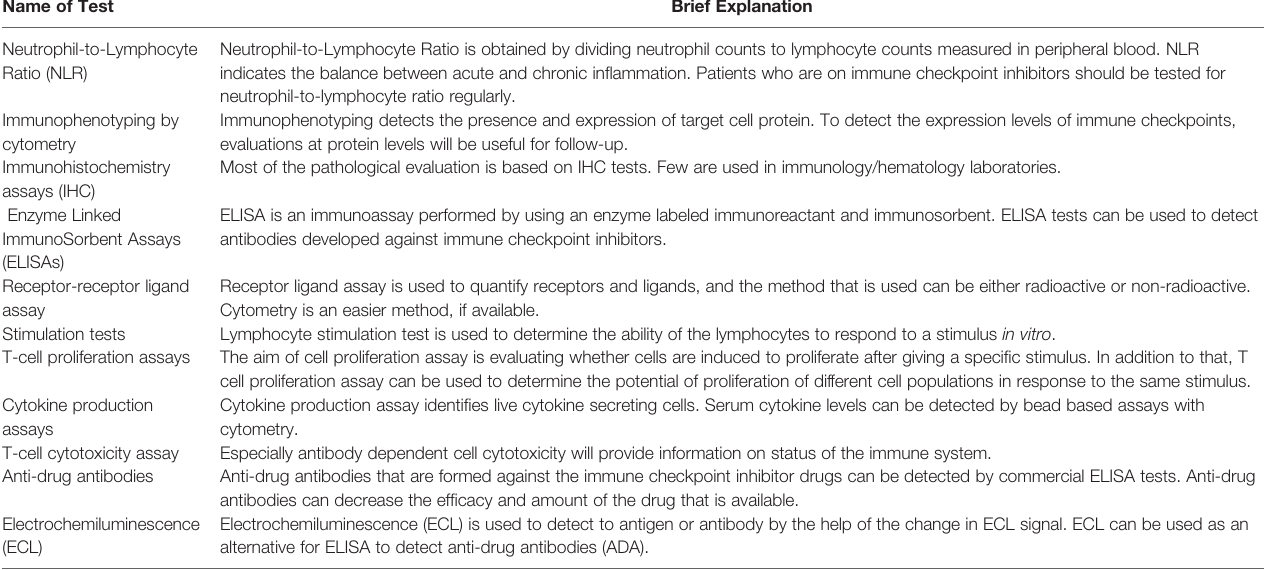
TABLE 1 | Suggested immunological tests for follow-up of patients administrating immune checkpoint